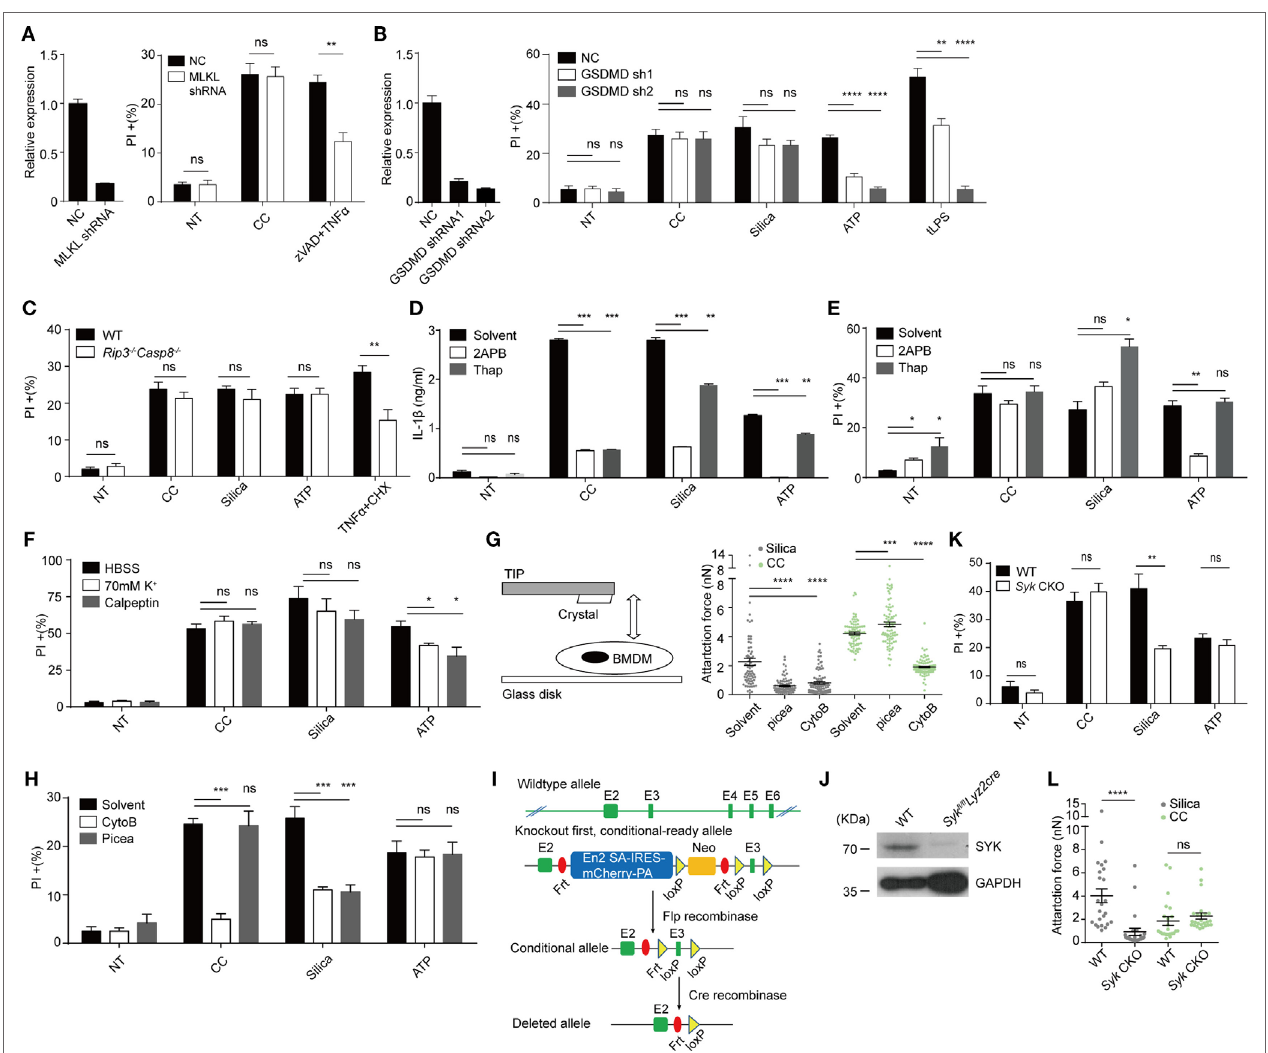
FigUre 3 | Cholesterol crystals (CC)-mediated cell death is unrelated to mixed lineage kinase domain-like kinase (MLKL), gasdermin D (GSDMD), CASP8, Ca 2 + influx, K + efflux and SYK. (a) Left: MLKL was knocked down in iBMDM by shRNA. Gene expression was determined by Q-PCR. Right: iBMDM were treated